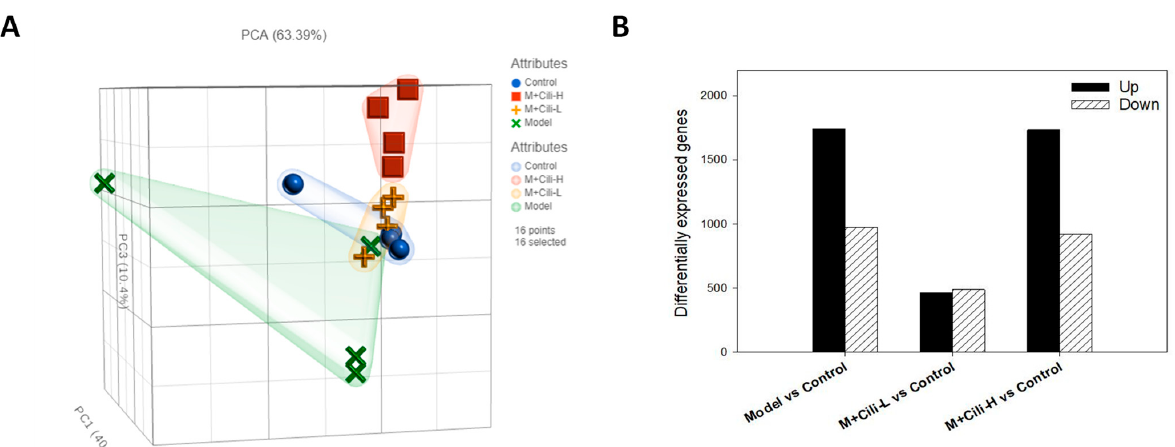
Figure 5. Differentially expressed gene (DEG) analysis. ( A ). Principle Component Analysis (PCA) of 16 samples (4/group); ( B ). Overview of DEGs as compared to the Control group under p value ≤ 0.05. Upregulated genes are in black bar, while downregulated genes are in shaded bar.